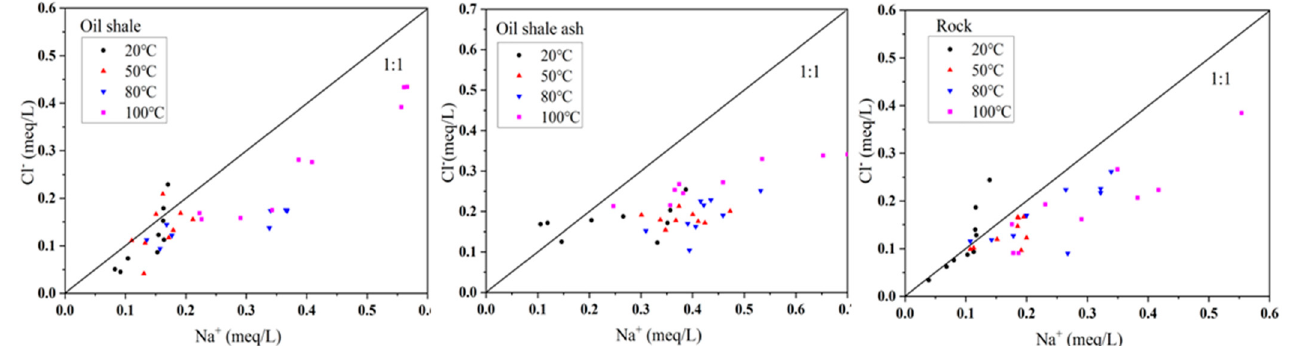
Figure 11. The ratio of Ca 2+ , Mg 2+ , and HCO 3 − in the aqueous solution under different reaction conditions.